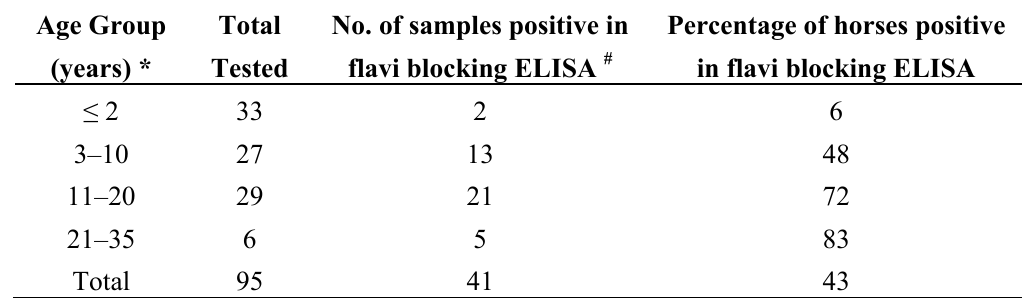
Table 1. Age distribution of horses from which sera was collected and assessed for antibodies to flaviviruses in blocking